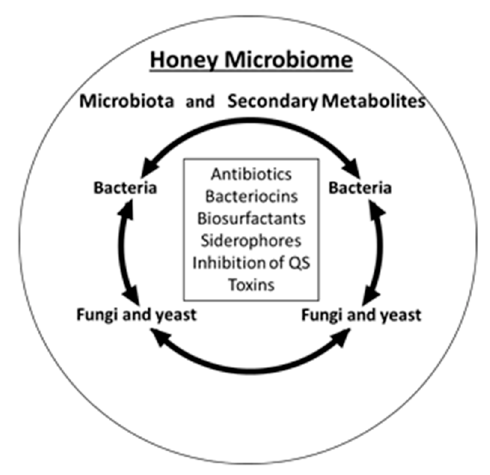
Figure 2. Honey microbiome presented as a combination of the microbial occupants of honey and the secondary metabolites they produce as a result of antagonistic, interspecies interactions and secrete to growth medium (honey) (figure adapted from [37]).